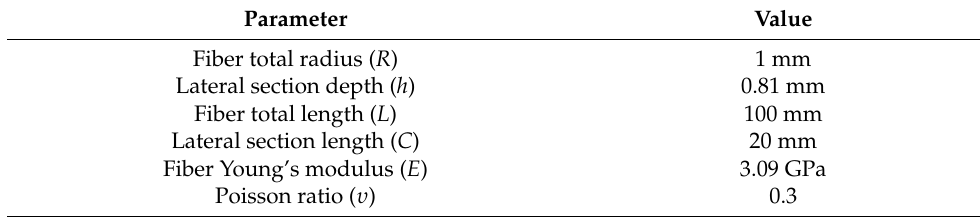
Table 1. Polymer optical fiber dimensions and mechanical